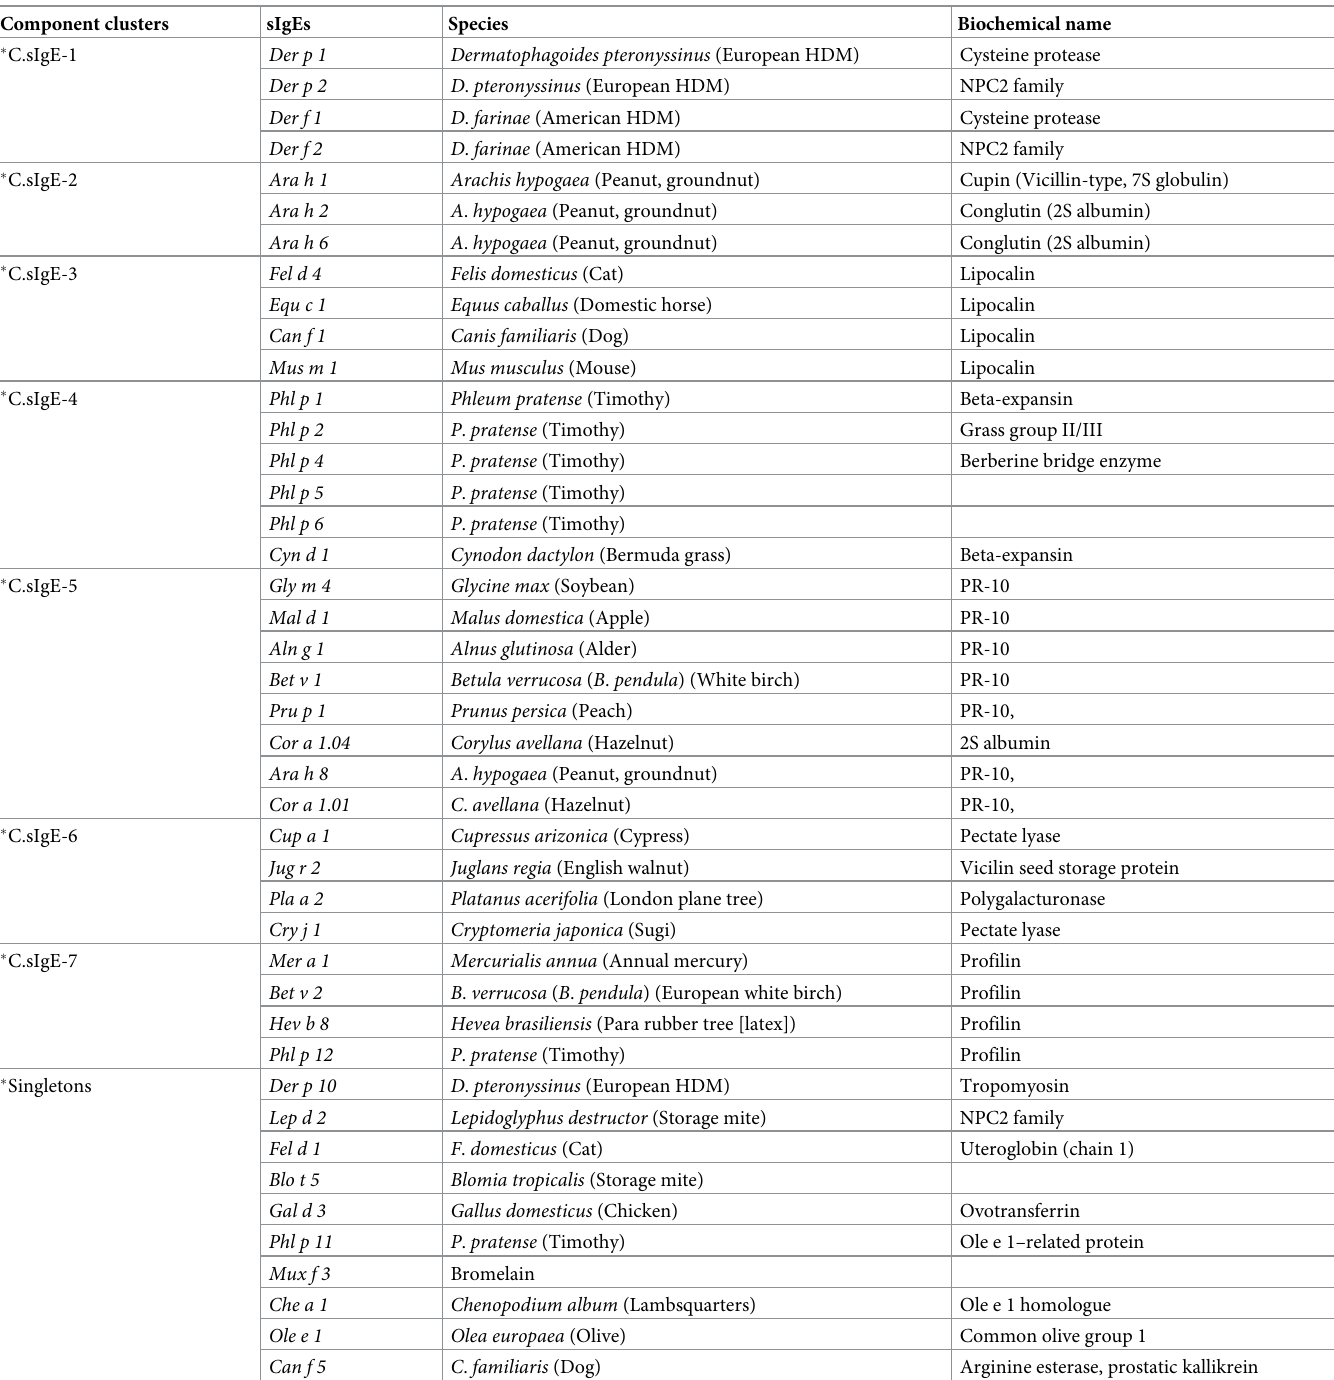
Table 1. Component-specific IgE clusters